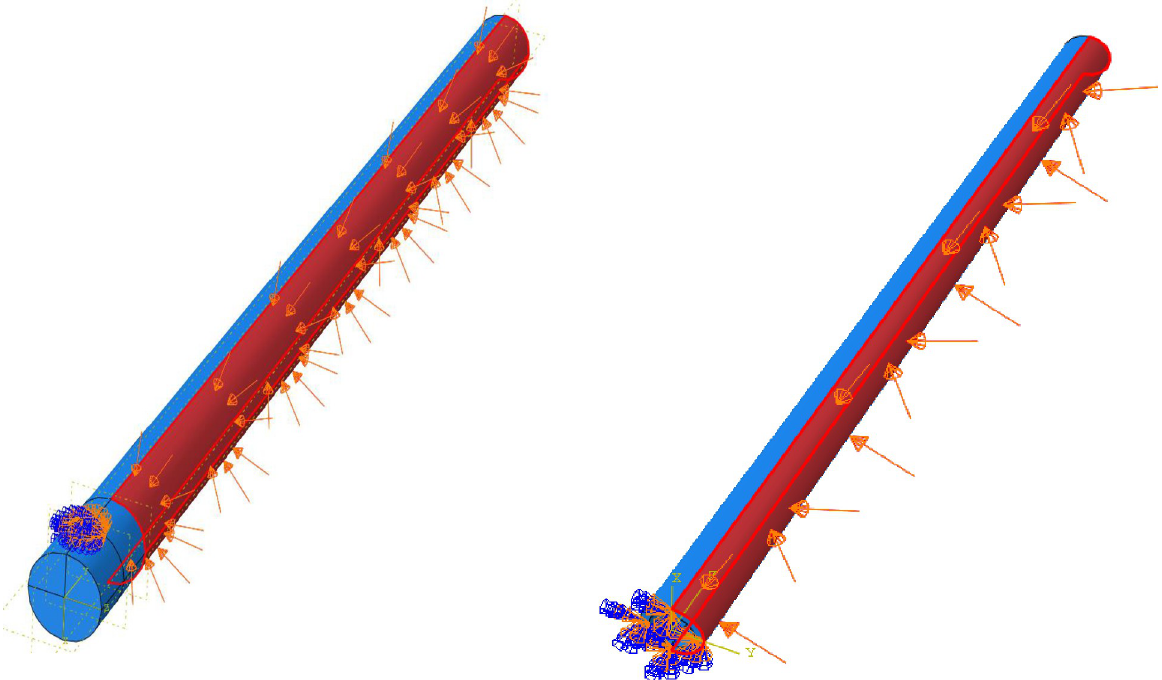
Fig 37. Pressure applied on the PP (left) and PVC pipe (right) in Abaqus.